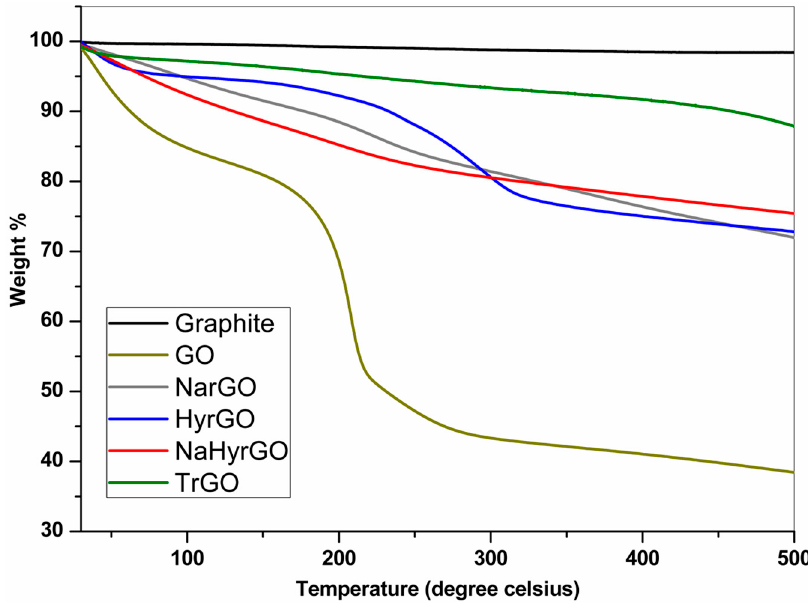
Figure 3. TGA curves of graphite, GO and different reduced GOs.